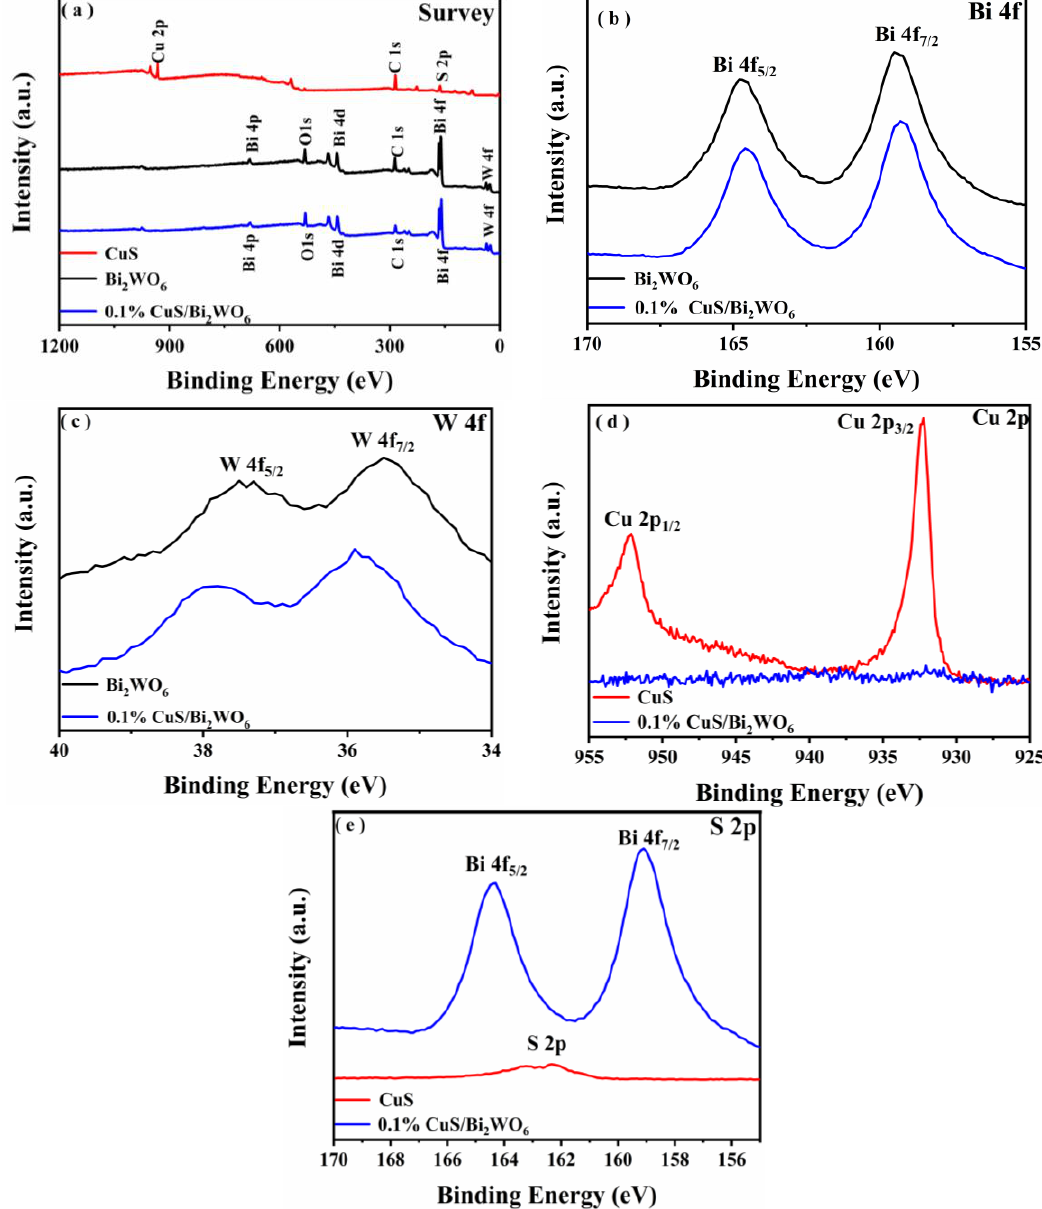
Figure 2. ( a ) The XPS survey spectra of Bi 2 WO 6 , CuS, and 0.1% CuS / Bi 2 WO 6 heterostructure ( b – e ) High resolution XPS spectra of the Bi 2 WO 6 , CuS, and 0.1% CuS / Bi 2 WO 6 heterostructure.